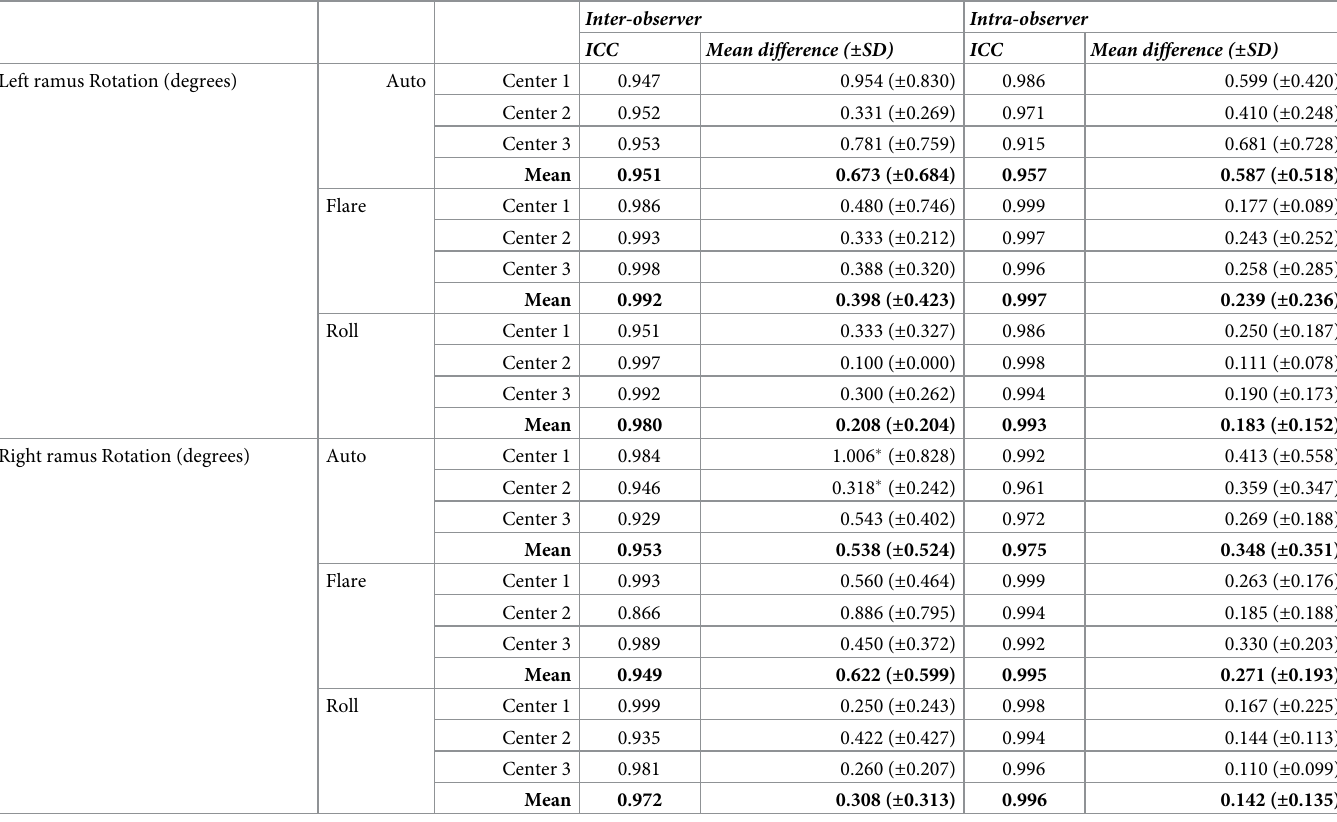
Table 6. Intra-observer and inter-observer differences and intraclass correlation coefficients (ICC) for measurements of the left and right ramus per center.